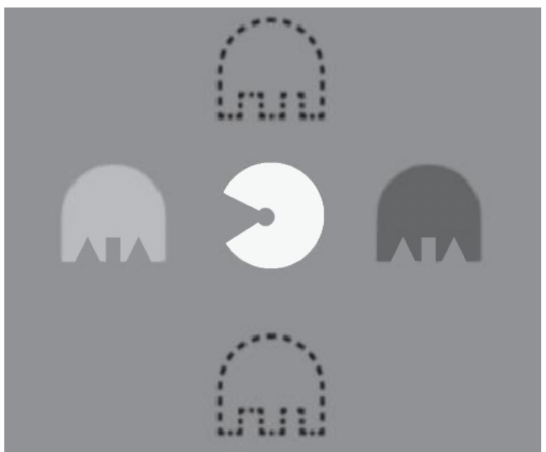
Figure 6. Illustration of VacMan flanked by two ghosts either positioned on the left and the right (as shown) or above and below (dashed outlines). Each ghost was a mixture of one dark and one light ghost presented to different eyes on each side (illustrated within the white circles). Suppression is quantified as the mixture of luminance required for the child to be equally likely to report either ghost as